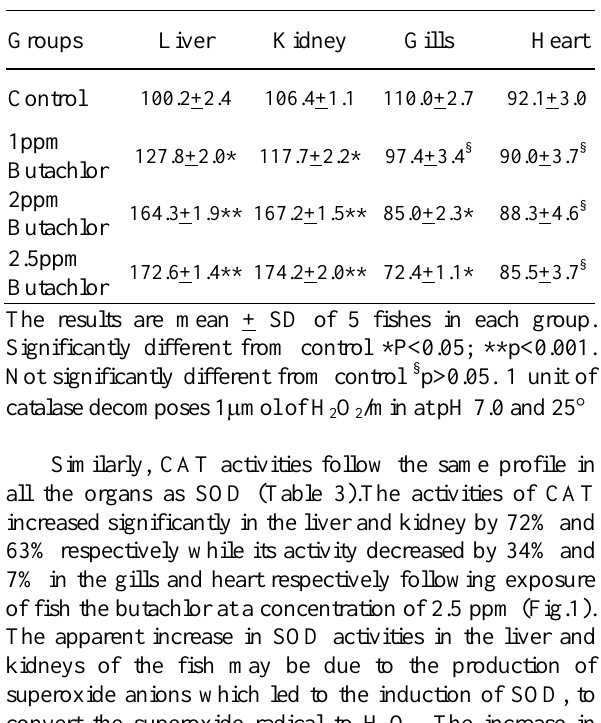
Table 3: The activity of Catalase (Units/mg protein) in the liver, kidneys, gills and heart of Clarias gariepinus exposed to Butachlor